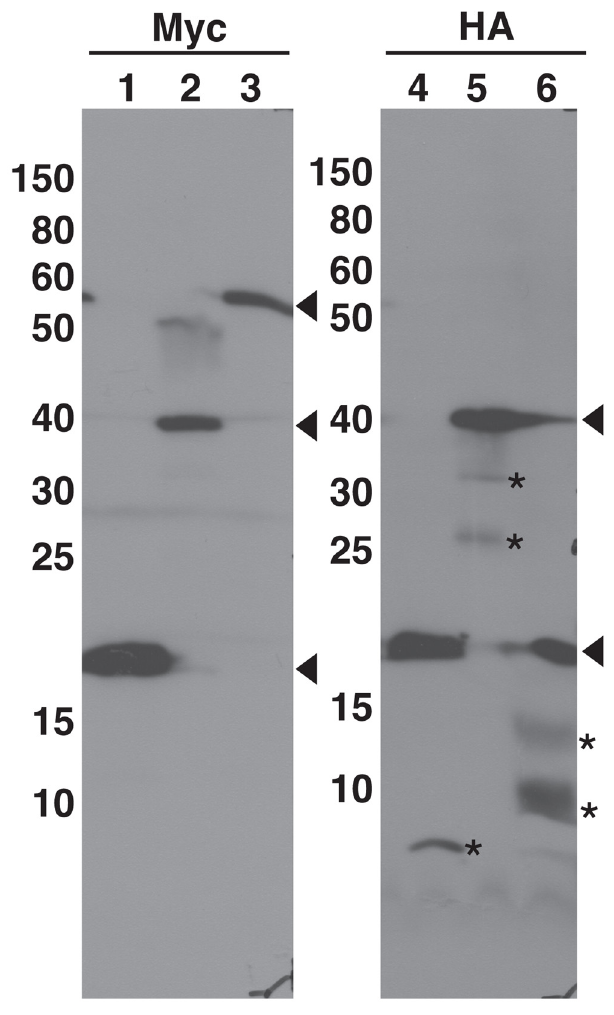
Fig 3. Immunodetection of transiently expressed nRFP/cRFP-fused proteins. Using protein extracts prepared from tobacco leaves of Agrobacterium-infiltrated plants analyzed in Fig 2, the accumulation of nRFP/cRFP-fused proteins by Agrobacterium infiltration was confirmed by immunoblot analysis with anti-Myc or anti-HA antibodies. Lane 1, nRFP; Lanes 2 and 5, PMP38-nRFP with PMP38-cRFP; Lanes 3 and 6, nRFP-PEX7 with PTS2-cRFP; Lane 4, cRFP. Arrowheads indicate the positions of untagged or tagged polypeptides. Asterisks represent extra polypeptides, which are considered to be degradation products of the fusion